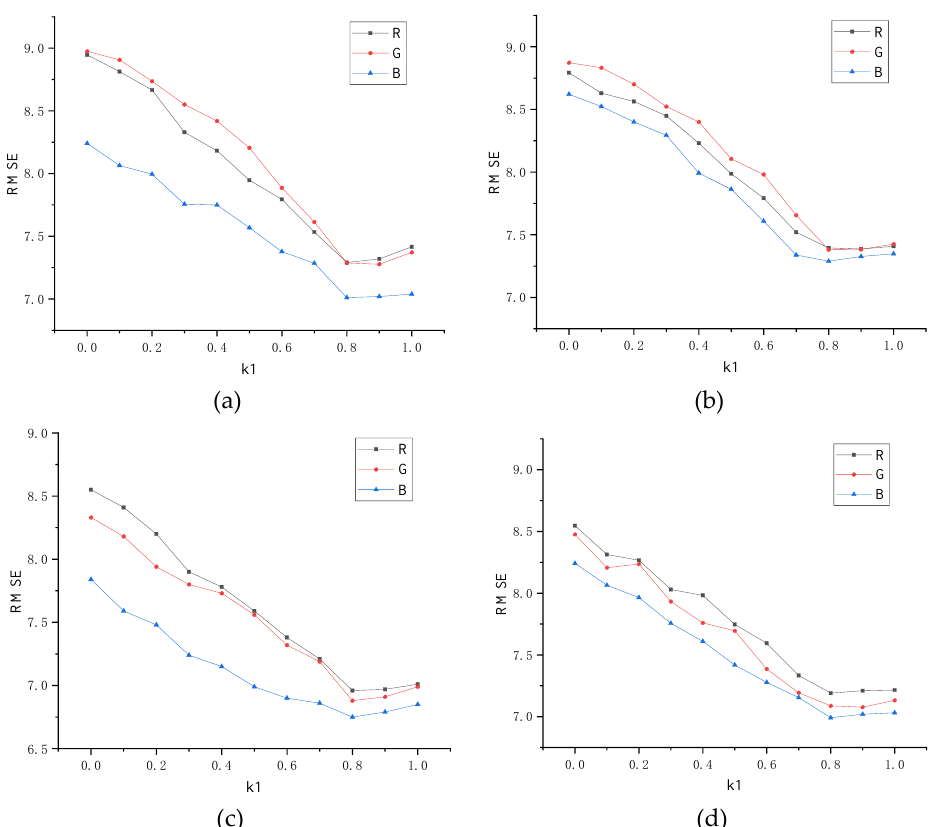
Figure 11. Sensitivity analysis of parameter k 1 in the four test regions: (a) ROI1; (b) ROI2; (c) ROI3; (d) ROI4